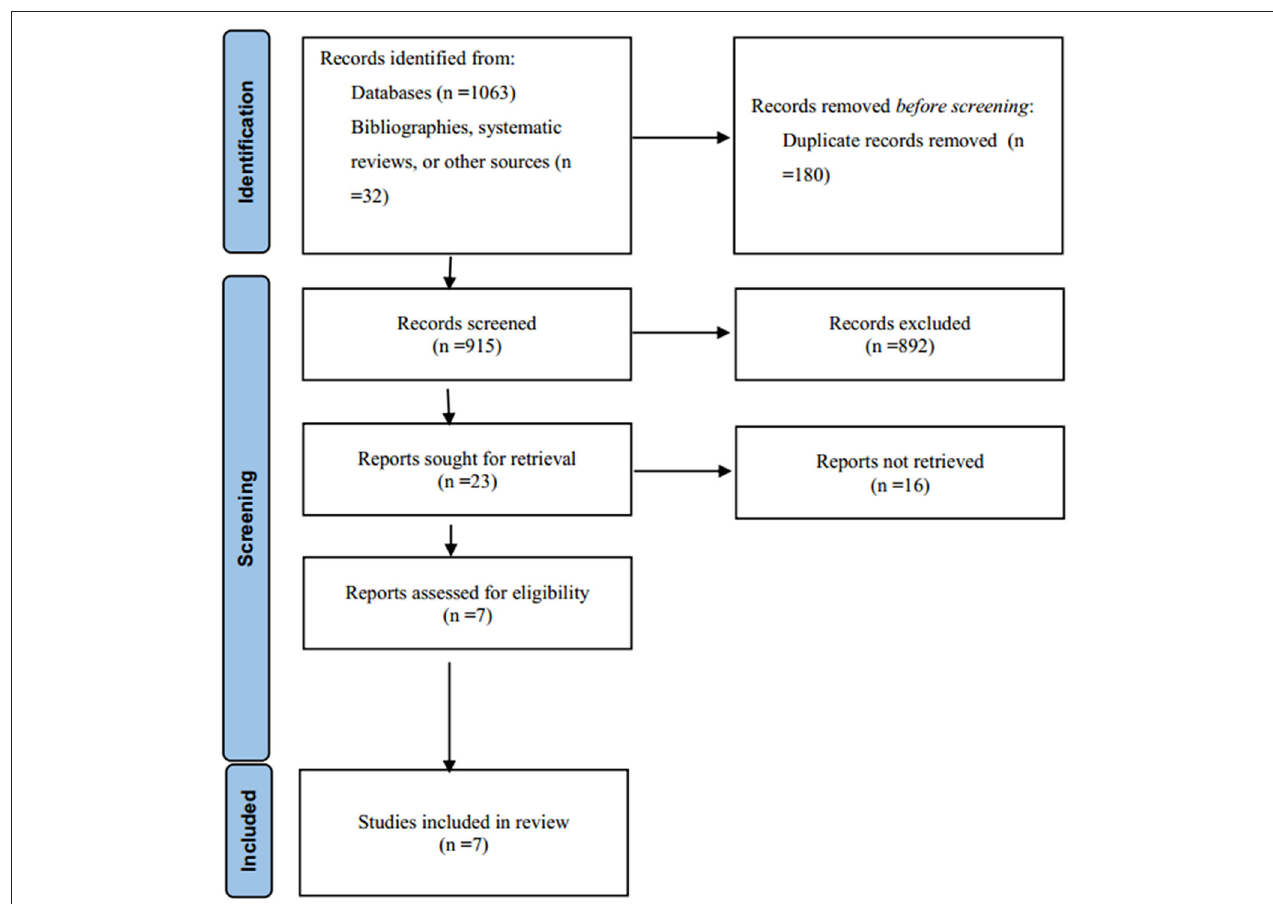
FIGURE 1 | Flowchart of the study selection process for inclusion in the meta-analysis.